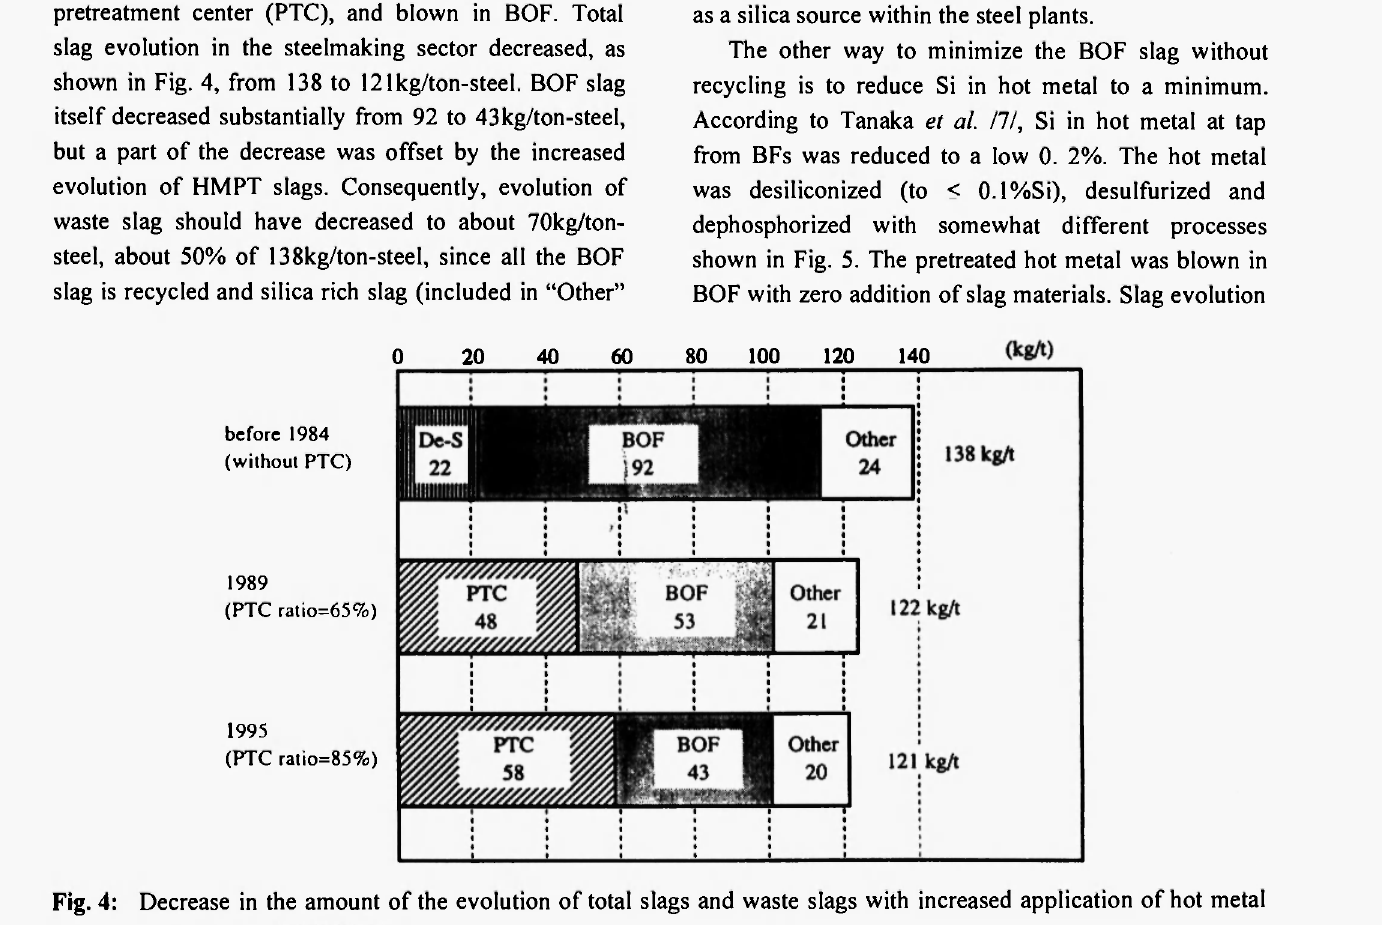
Fig. 4: Decrease in the amount of the evolution of total slags and waste slags with increased application of hot metal pretreatment (HMPT) 161.